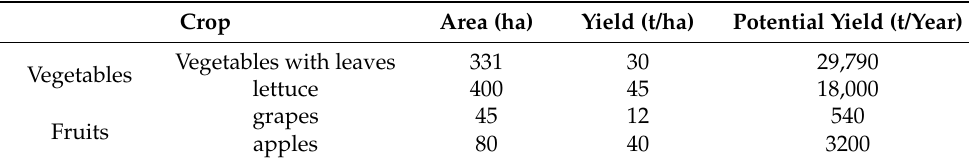
Table 5. The potential yield of fruits and vegetables in the software model. Crop Area (ha) Yield (t/ha) Potential Yield (t/Year) Vegetables with leaves 331 30 Vegetables lettuce